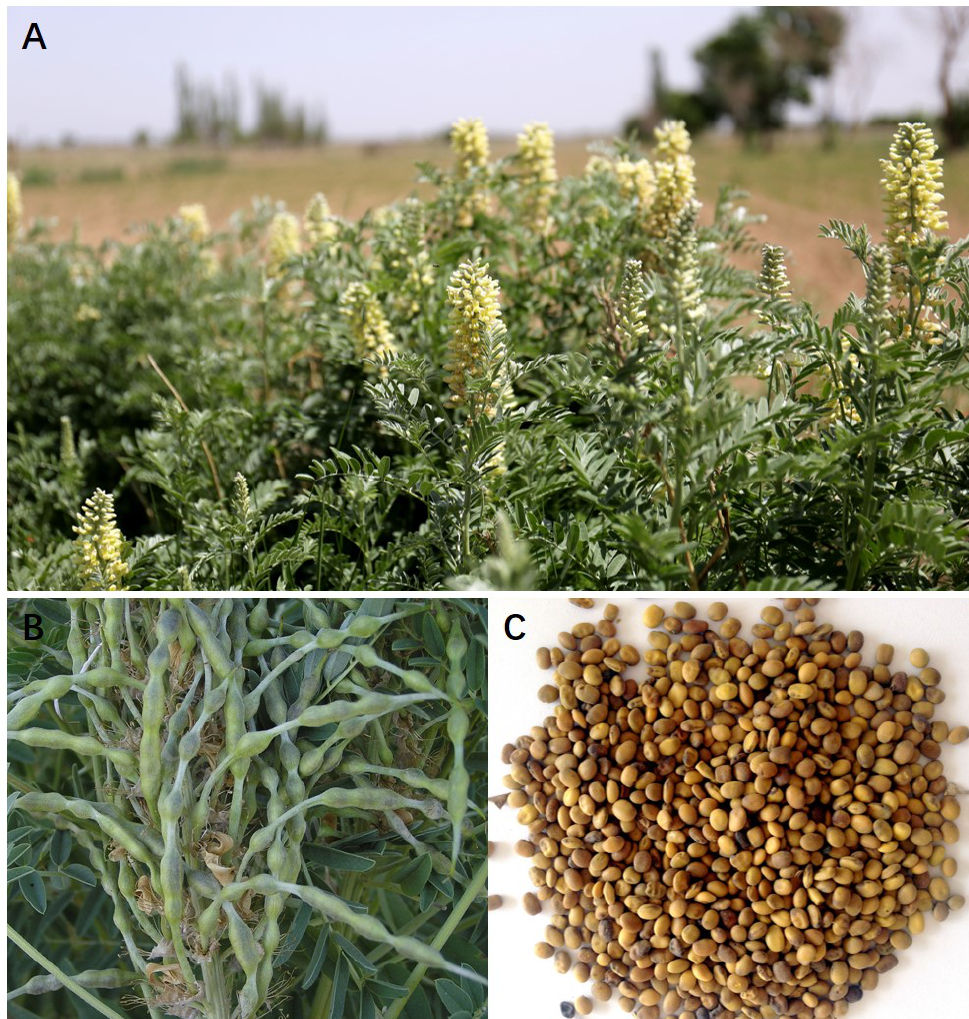
Figure 1. Sophora alopecuroides plant characteristics : ( A ) flowering branches and habitats, ( B ) fruits, and ( C ) seeds (bean).